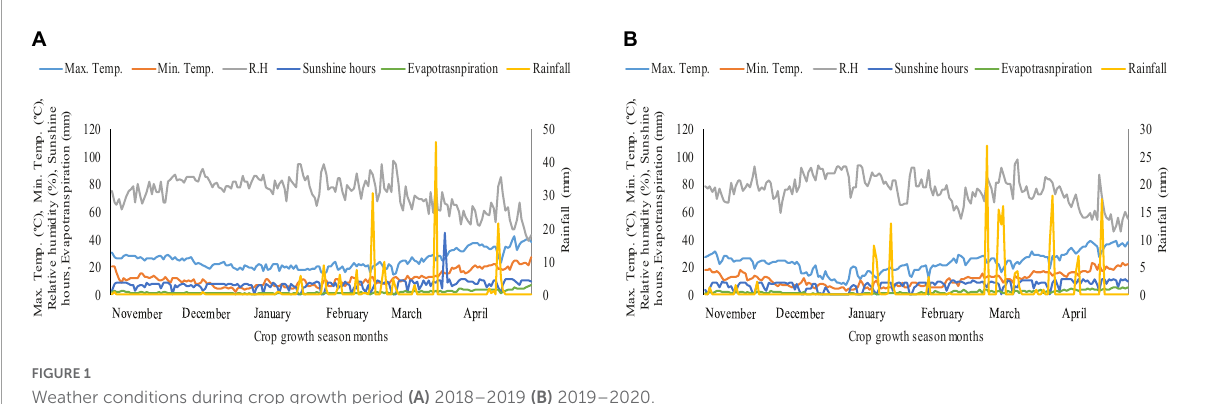
TABLE 1 Effect of optimal and stressful conditions of pots, potassium (K) spray and cultivars on superoxide dismutase (SOD U mg − 1 protein), peroxidase (POD U mg − 1 protein), catalase (CAT U mg − 1 protein), and total soluble sugars (TSS mg/g of DW) of wheat flag leaves under 4 and 8 days of heat stress 1 week after anthesis. Thermal regimes